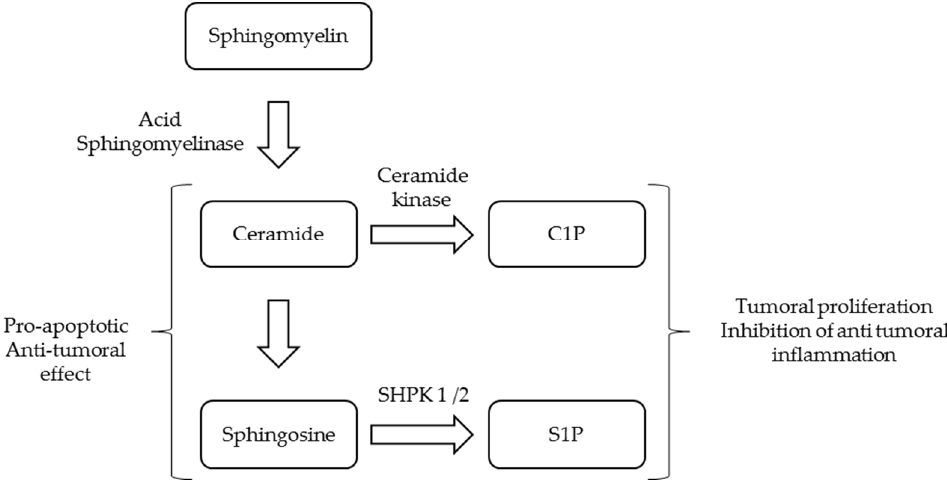
Figure 2. The role of ceramide and its derivatives in cancer development (C1P: ceramide-1-phosphate; S1P: sphingosine-1-phosphate; SPHK: sphingosine kinase).